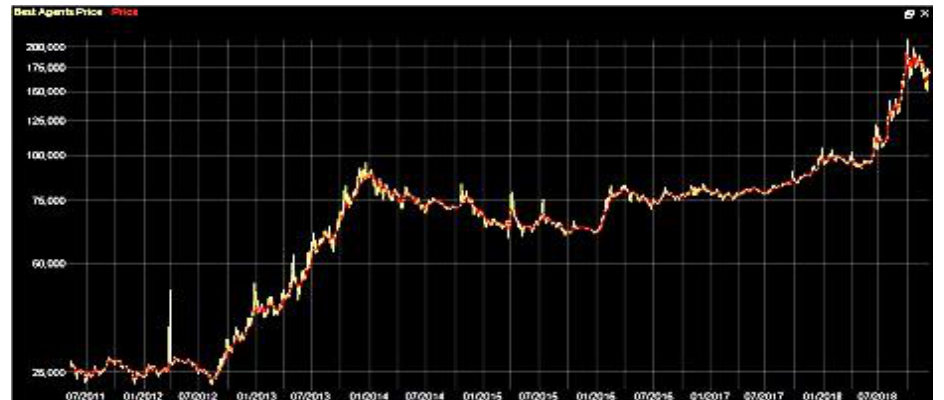
Fig.1. Time series plot of “TEPIX” at 5% Best Agents group size; the red curve is historical “TEPIX” quotes; the yellow curve is the series estimated by agents